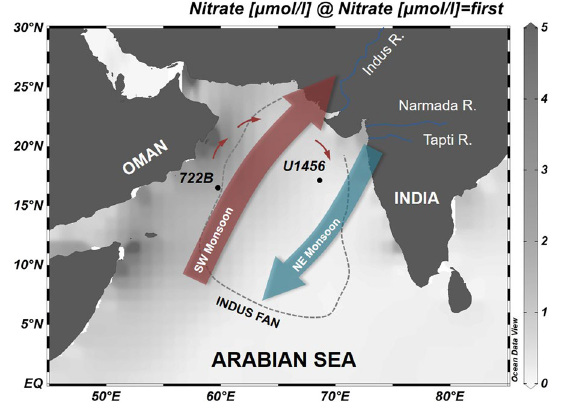
Figure 1. IODP Expedition 355 Site U1456 and ODP Leg 117 Site 722B in the Arabian Sea with seasonal wind patterns of the Indian Monsoon. Site U1456 (16°37.28 ′ N, 68°50.33 ′ E, 3640 m below sea level) is located in the Eastern Arabian Sea and Site 722B (16°37.31 ′ N, 59°47.76 ′ E, 2028 m below sea level) is situated in the Western Arabian Sea. The gradation in the sea represents annual nitrate content of the surface water in the Arabian Sea. The grey dotted line represents the outline of the Indus Fan. The small red arrow symbolizes the Somali